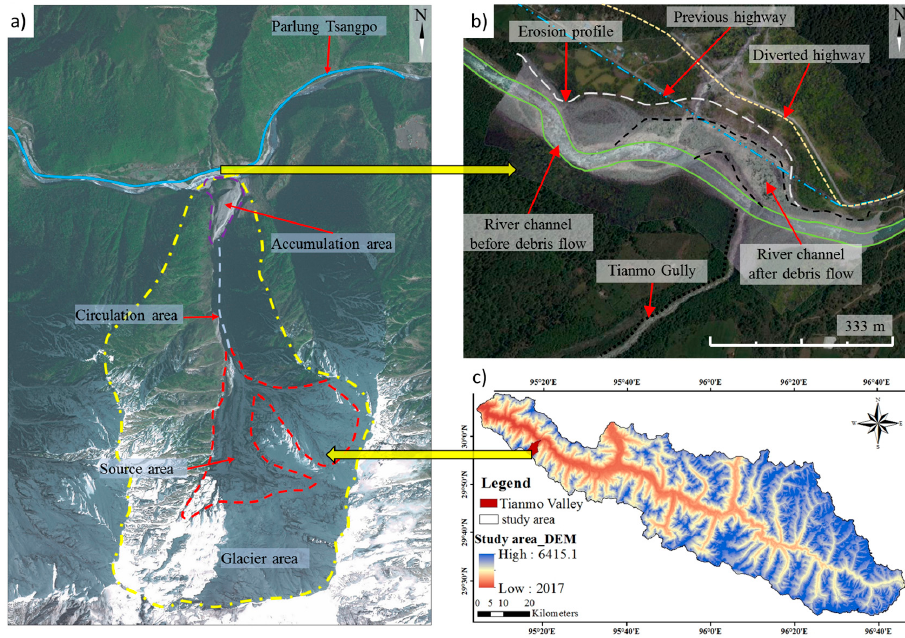
Figure 1. ( a ) High-resolution image of Tianmo Watershed; ( b ) Plan view junction between Tianmo tributary and Parlung Tsangpo River in 2010 and 2017 in Google Earth Imagery (acquisition date: 10 January, Image © 2018 DigitalGlobe); ( c ) Geomorphologic information of Parlung Tsangpo River and the related tributary.